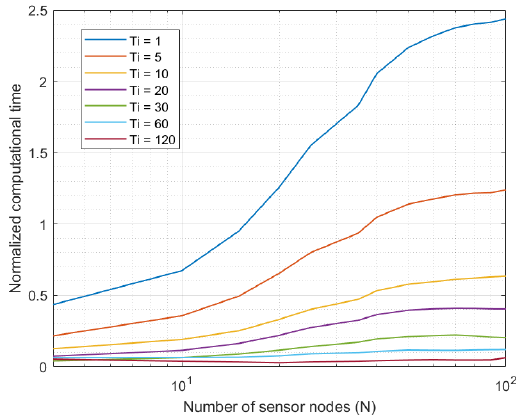
Figure 3. Results of the first experiment.